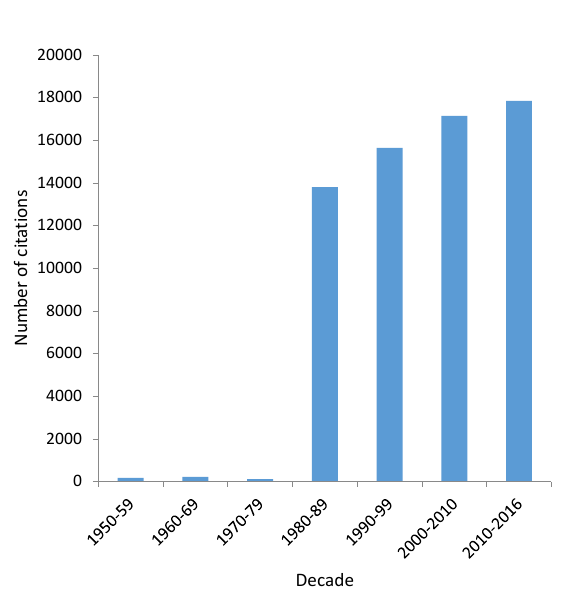
Figure 1. Temporal Trends in the Publication of Most Cited